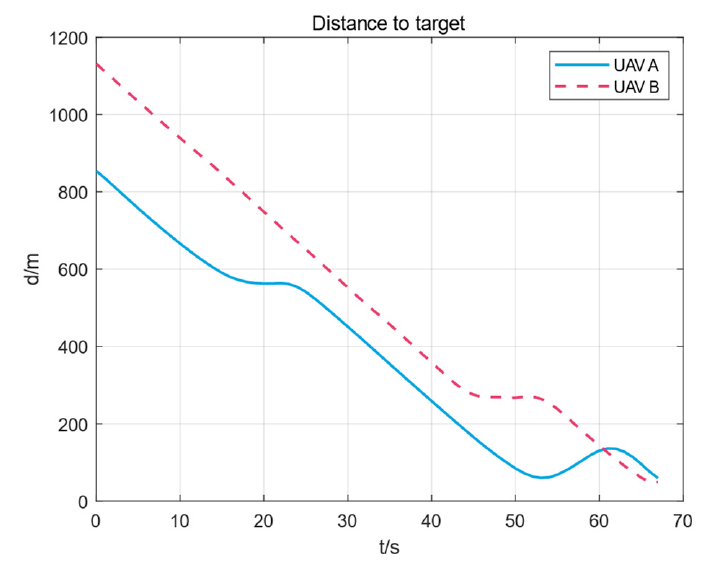
Figure 11. The distance curve between the UAV and the target.